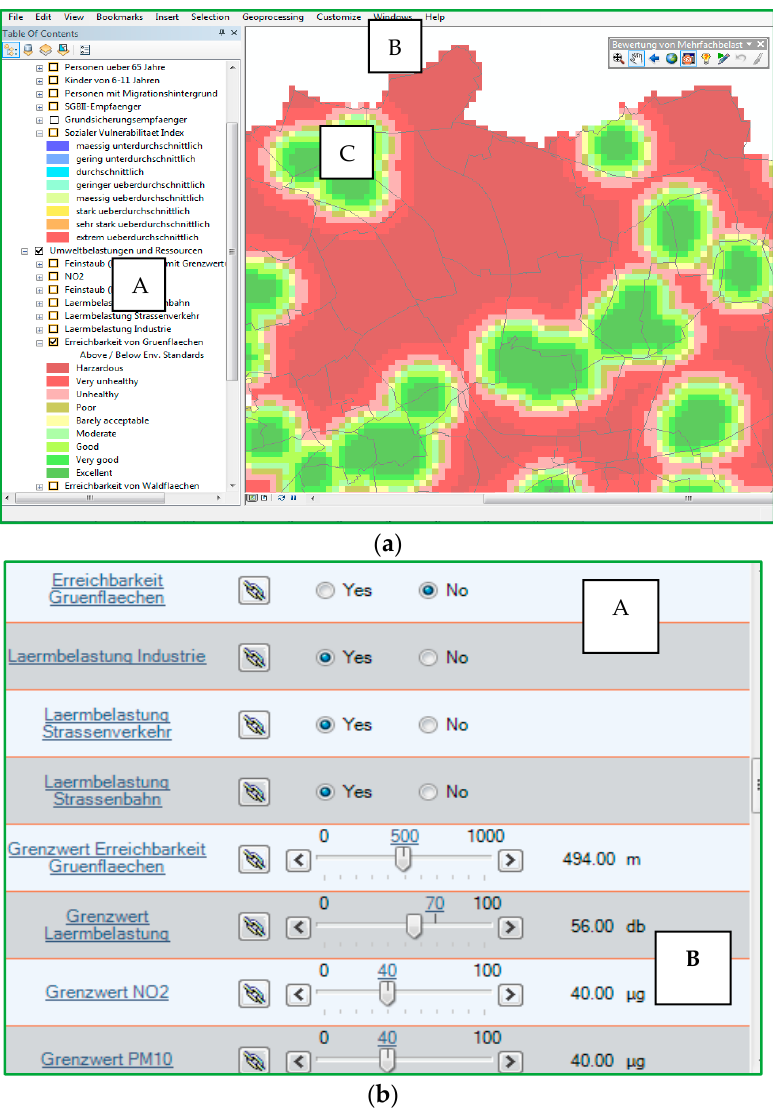
Figure 2. ( a ) User interface for A-overlaying indicators/index, B-manoeuvring on the maps, C-dynamic visualization of 2D maps; ( b ) Interactive tools for A-selecting indicators to construct index, B-changing thresholds.